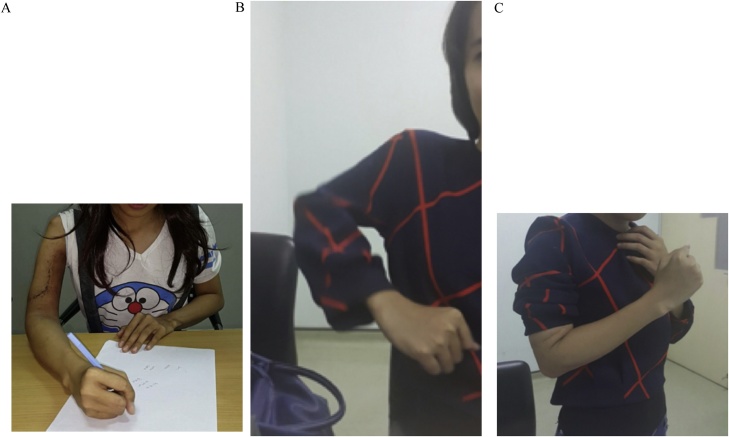
3 Years follow up.